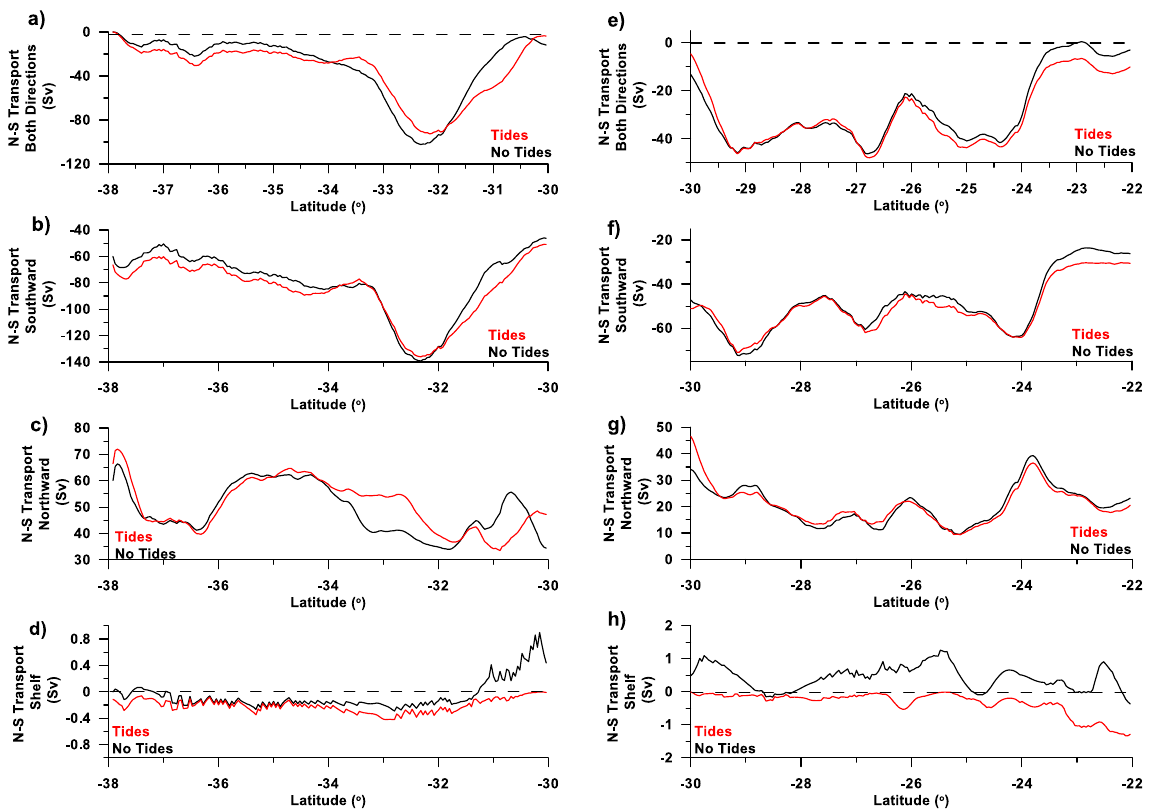
Fig. 3 Integrated North–South transports west of 155 ° E for water depths greater than 200m for the a net transport, b southward transport, and c northward transports for the tidal (red) and non-tidal (black) simulations South of 30 ° S. d The integrated North–South net transport west of 155 ° E at the continental shelf break for the tidal (red) and non-tidal (black) simulations south of 30 ° S. e – h The same parameters as a – d North of 30 o S,